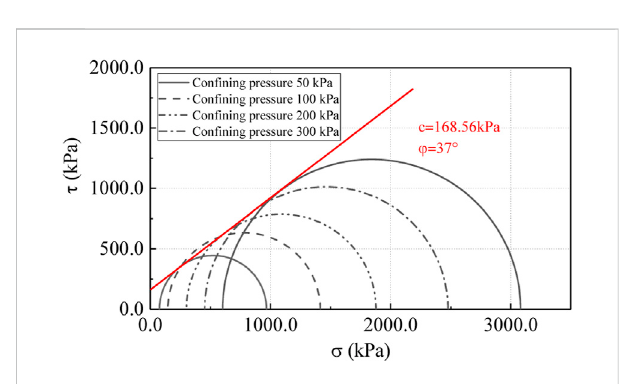
FIGURE 15 Shear strength of 7 days curing age specimen.